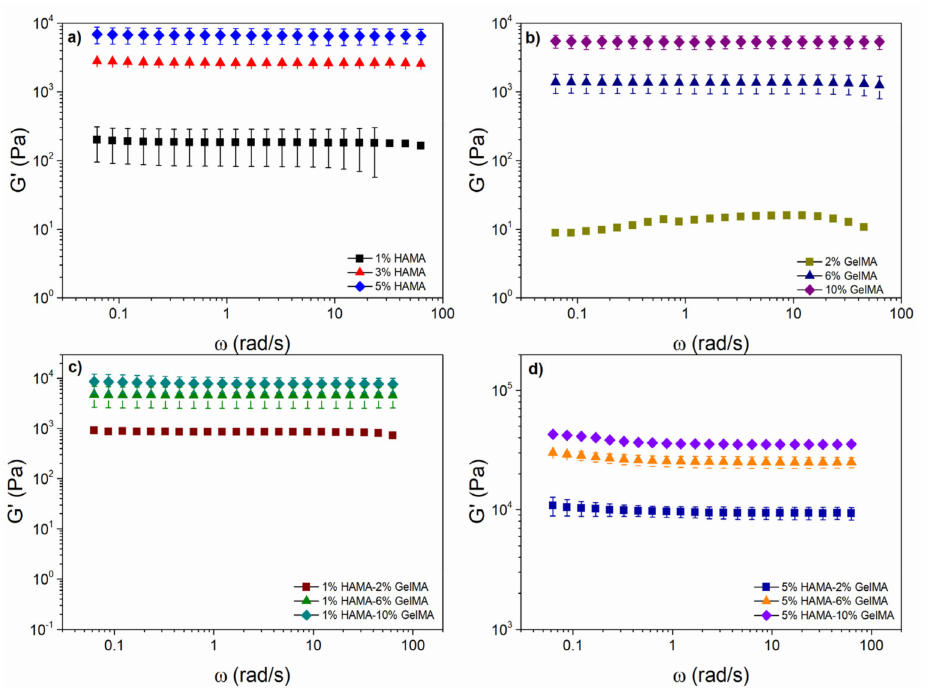
Figure 5. Storage modulus as a function of frequency and ( a ) HAMA concentration; ( b ) GelMA concentration; ( c ) 1%HAMA-X% GelMA; and ( d ) 5% HAMA-X% GelMA. Performed at a deformation within the linear viscoelastic region (LVR) and a temperature of 37 ◦